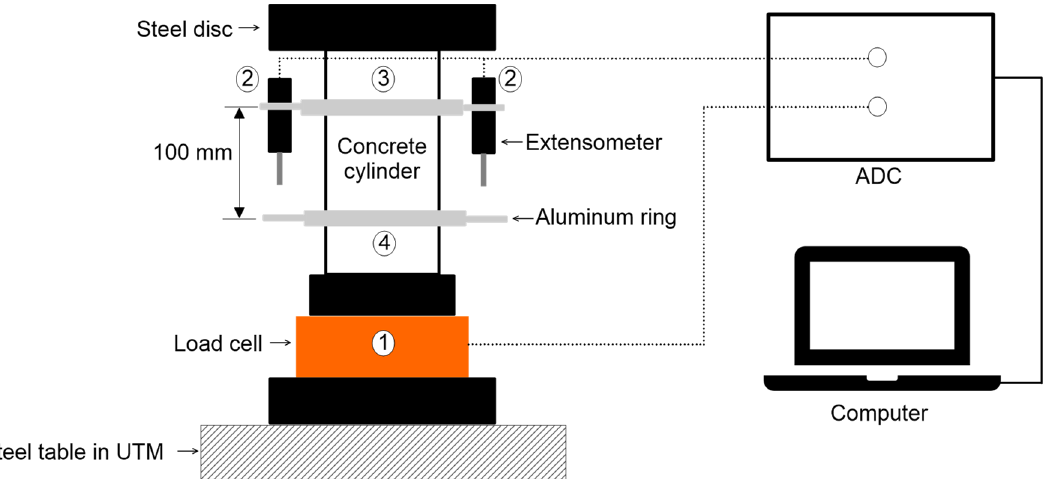
Figure 5. Test setup for the uniaxial compressive test for measurements of compressive strength and static modulus of elasticity of concrete